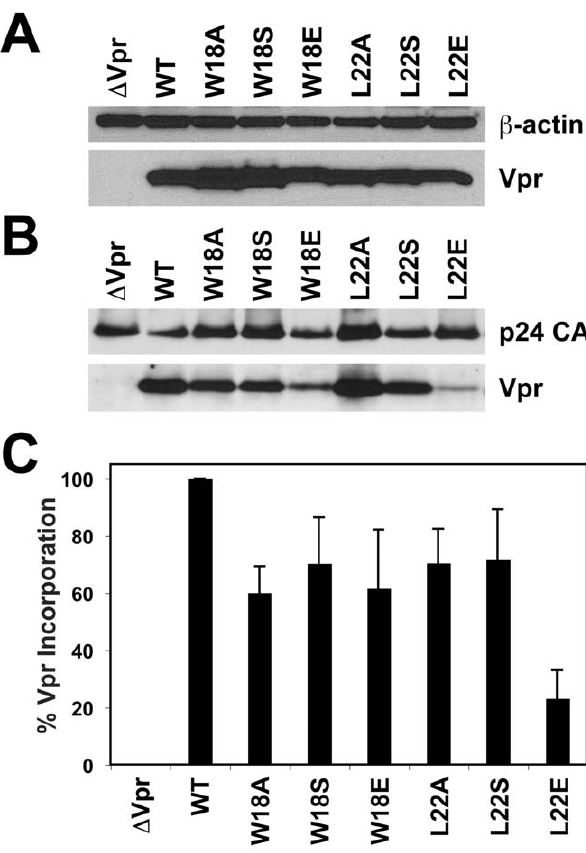
Figure 1. The NMR structure of Vpr shows solvent exposed hydrophobic residues along helices 1 and 3. ( A ) A wire and box diagram of Vpr. The gray boxes represent the 3 helices of Vpr, and the upper set of numbers denotes the boundaries of each helix. The lower set of numbers identifies exposed hydrophobic residues along helix 1 and helix 3. ( B ) A tube diagram of the side view of the nuclear magnetic resonance (NMR) structure of HIV-1 Vpr (PDB: 1M8L) indicating hydrophobic amino acids exposed on the apparently solvent exposed surfaces of helix 1 (red) and helix 3 (blue). ( C ) A space filling diagram of the side view of HIV-1 Vpr using a hydrophobicity color scheme. The exposed hydrophobic residues along helices 1 and 3 are colored as in (B). Positively charged or polar amino acids with high hydrophilicity are colored light blue. Purple residues are negatively charged with high hydrophilicity. Polar amino acids with low to neutral hydrophobicity are gray, and highly hydrophobic, nonpolar residues are brown. The a -